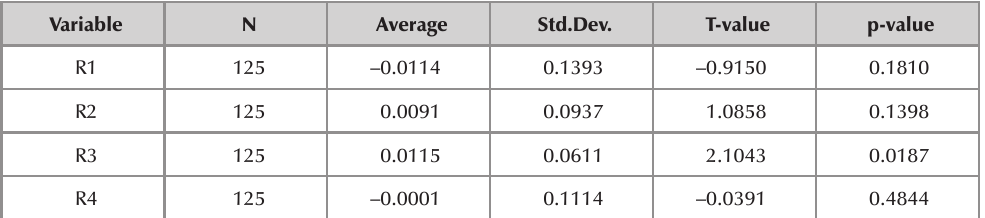
The average values of CAR for different windows relative to the announcement of 125 BEE